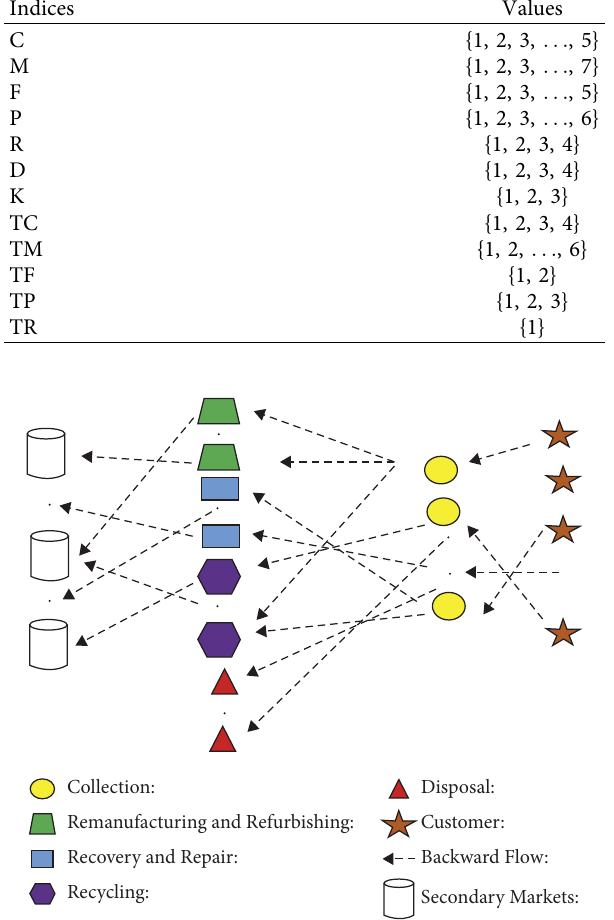
Figure 5: Locations of RN facilities in small